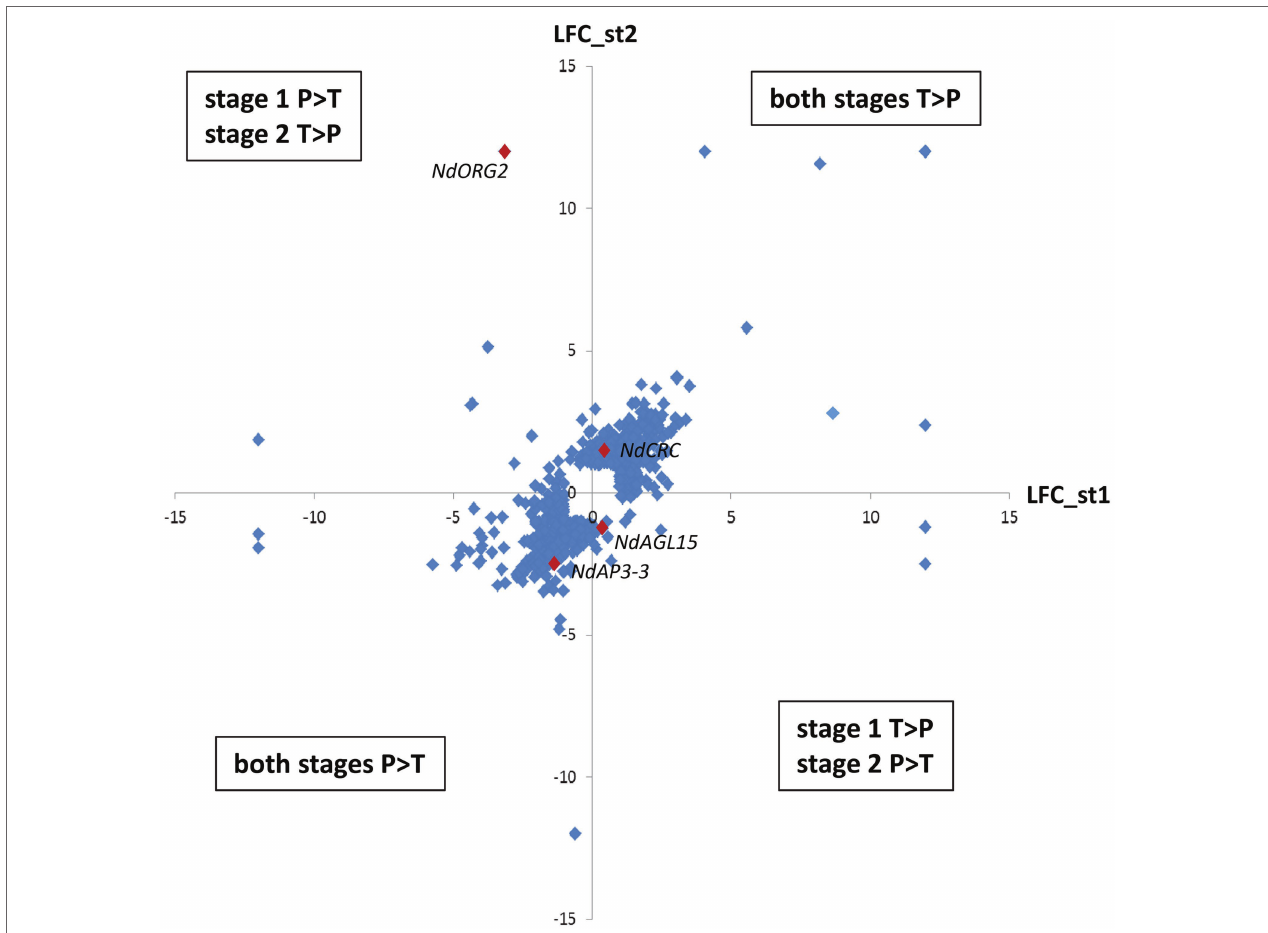
FIGURE 3 | Differential expression between morphs at the two developmental stages for the most differentially expressed genes. Differential expression is expressed by Log2fold change, and only genes with |M_LFC| > 1 at one or both developmental stages are represented. The y-axis represents differential expression between the two morphs at stage 2 and the x-axis represents differential expression at stage 1. The upper right quadrant includes genes more expressed in the T morph at both stages, while the lower left quadrant includes genes more expressed in the P morph at both stages. The two other quadrant group genes that have reversed differential expression between the two morphs at the two stages. Examples of genes illustrating these situations are represented by red diamonds. Genes not expressed at one stage have been arbitrarily attributed M_LFC = +12: (T morph) or − 12: (P